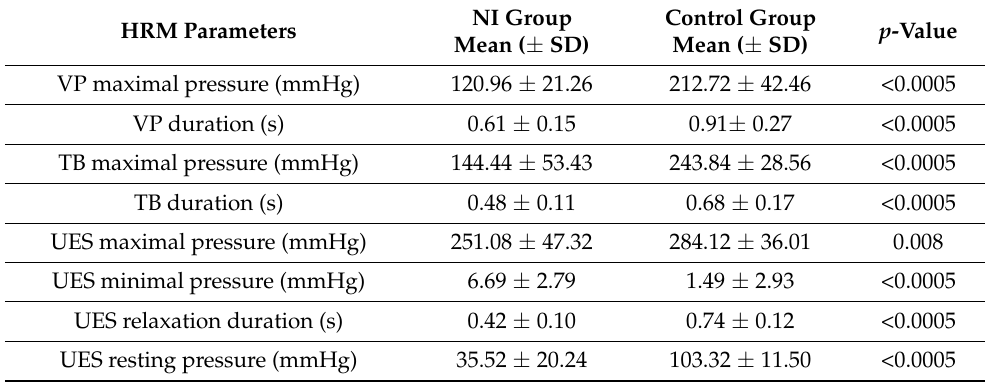
Table 2. Comparison of HRM parameters between NI children and control